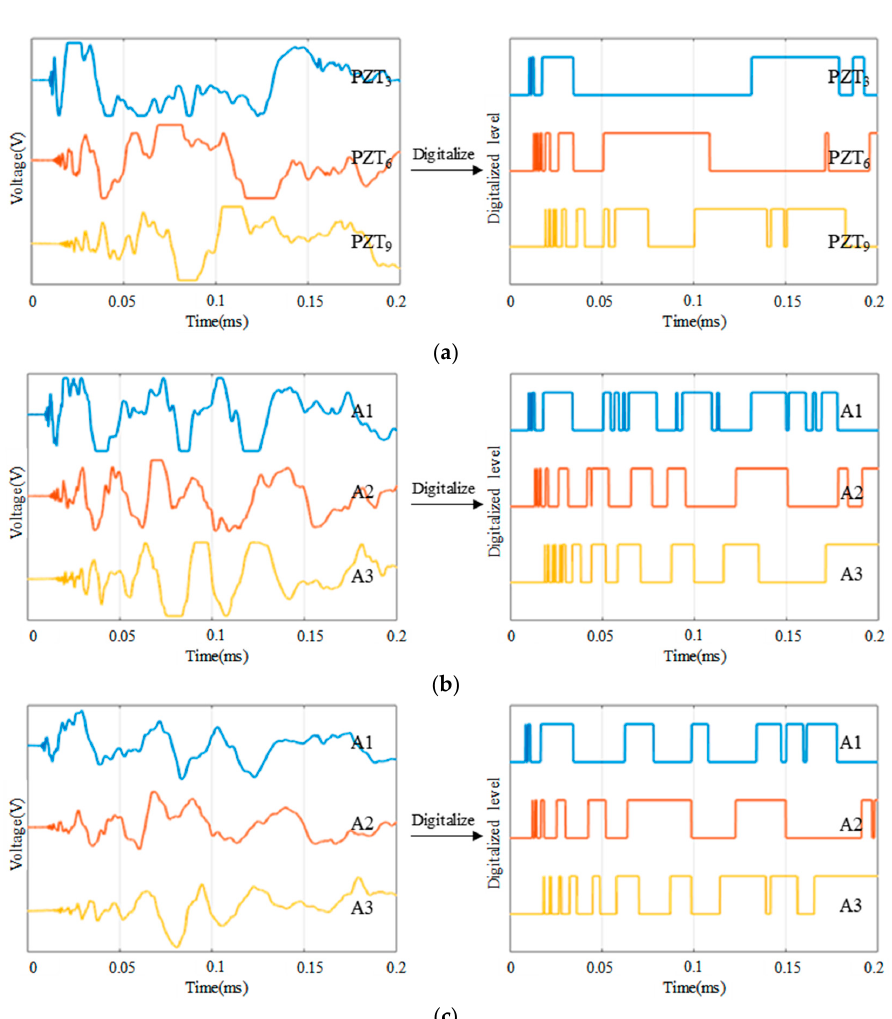
Figure 9. Typical impact response signals and CDSs of different sensor connection types under impact energy level 2: ( a ) The impact response signals and CDSs of PZT 3 , PZT 6 and PZT 9 in independent connection type; ( b ) The impact response signals and CDSs of A1, A2 and A3 in series connection type; ( c ) The impact response signals and CDSs of A1, A2 and A3 in parallel connection type.